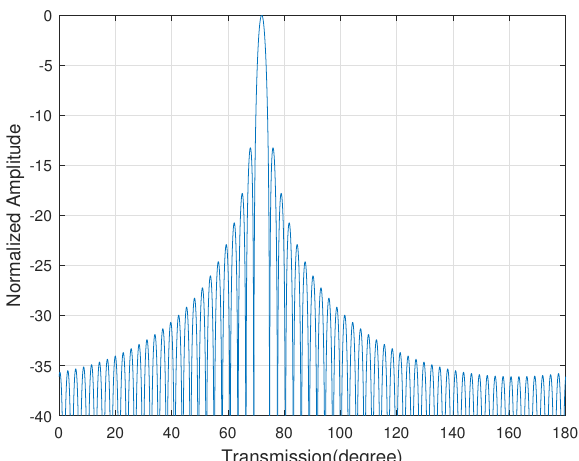
Figure 2. The radiation pattern of the traditional analog beamforming